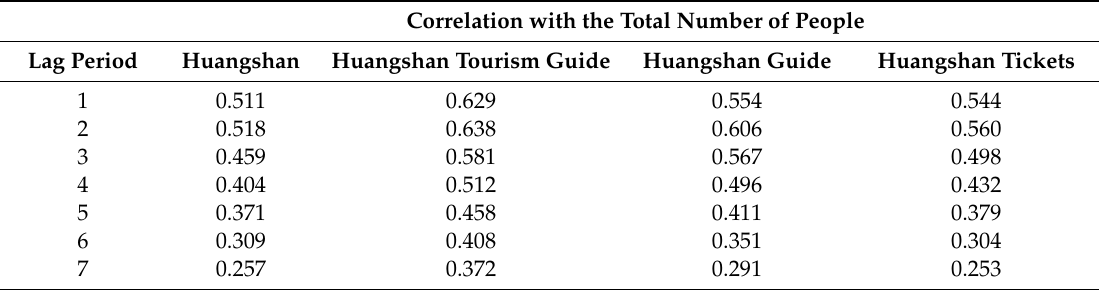
Table 3. Results of the correlation analysis of di ff erent lag